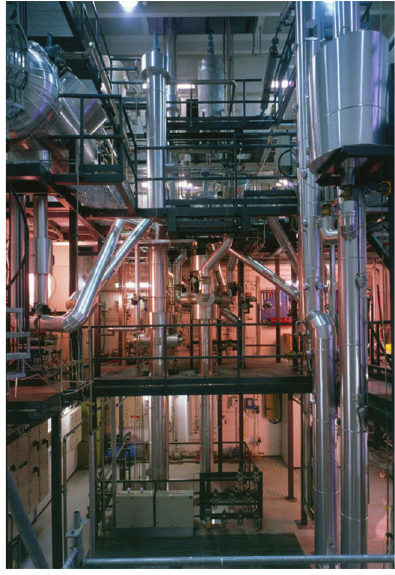
Figure 1: PACTEL facility in laboratory.